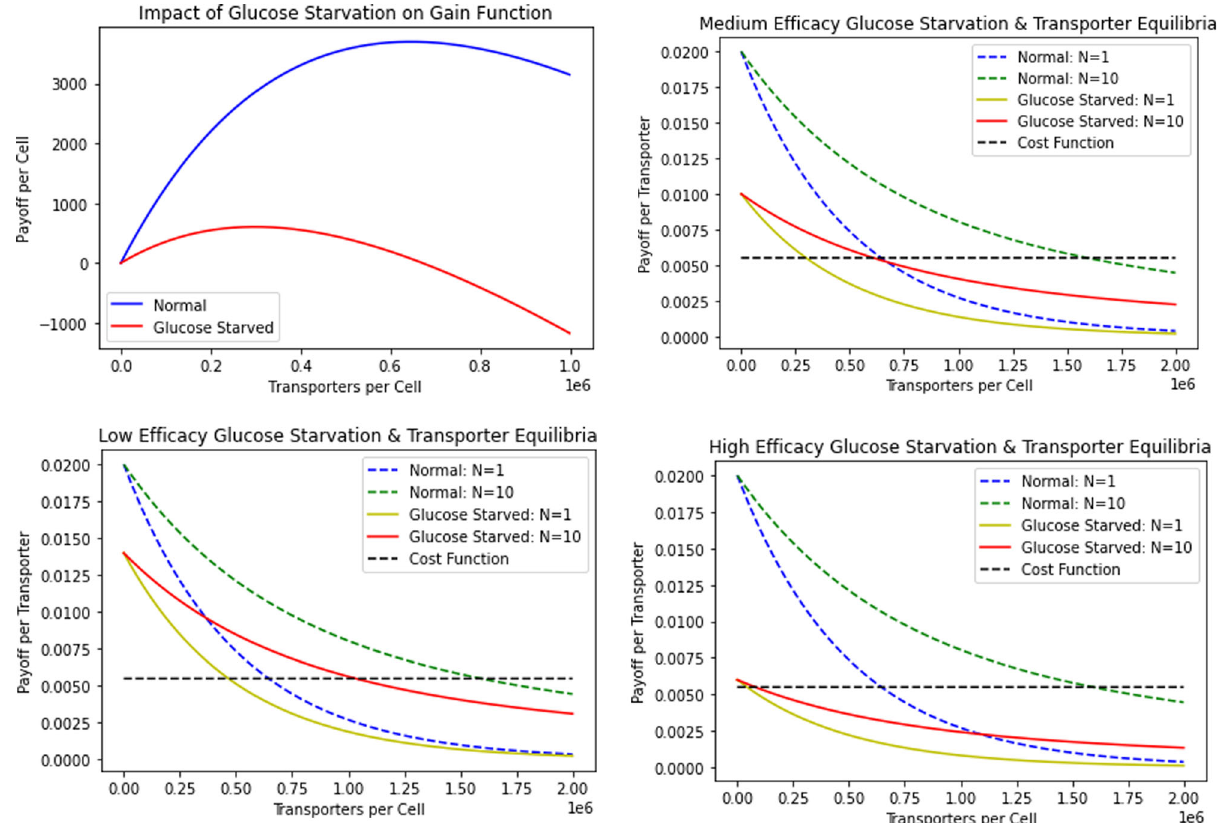
Fig. 6 Impact of glucose starvation. Therapy results in a lower payoff curve per cell in a glucose-starved environment. The ESS number of transporters per cell is lower under glucose starvation than under normal